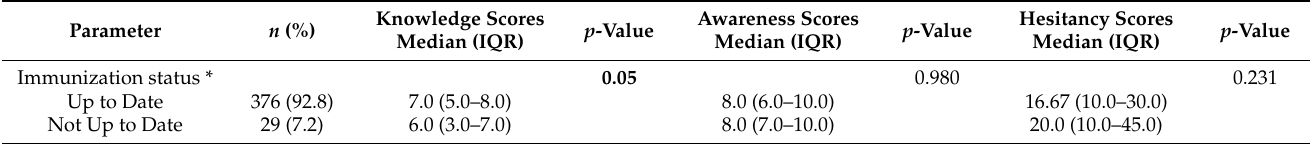
Table 4. Total Vaccine Knowledge, Awareness and Hesitancy Score Differences between Children’s Immunization Status Groups.